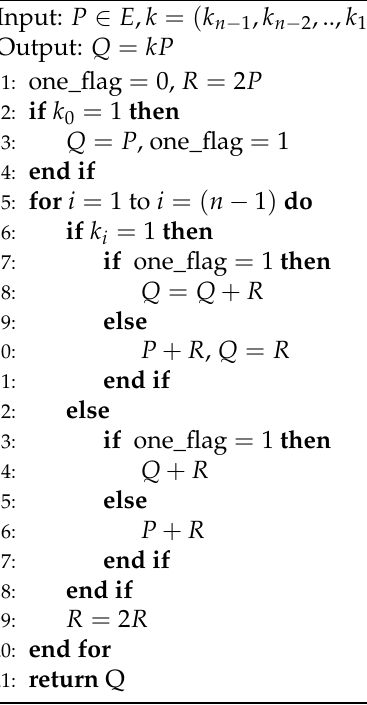
Algorithm 3 Modified Double-and-Add-Always Right-to-Left.